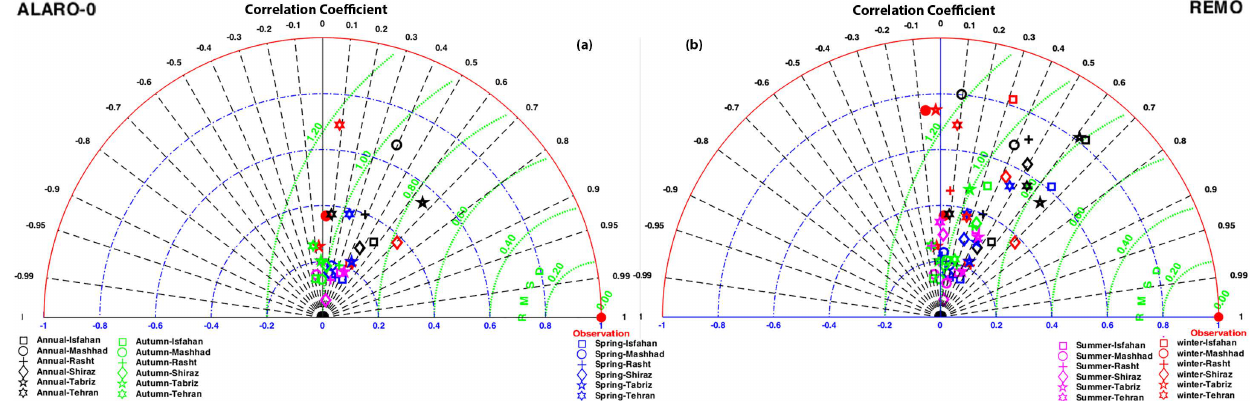
Figure 16. Taylor diagram of average annual/seasonal wind velocity comparing ALARO-0 ( a ) and REMO ( b ) models with observations over six studied stations.